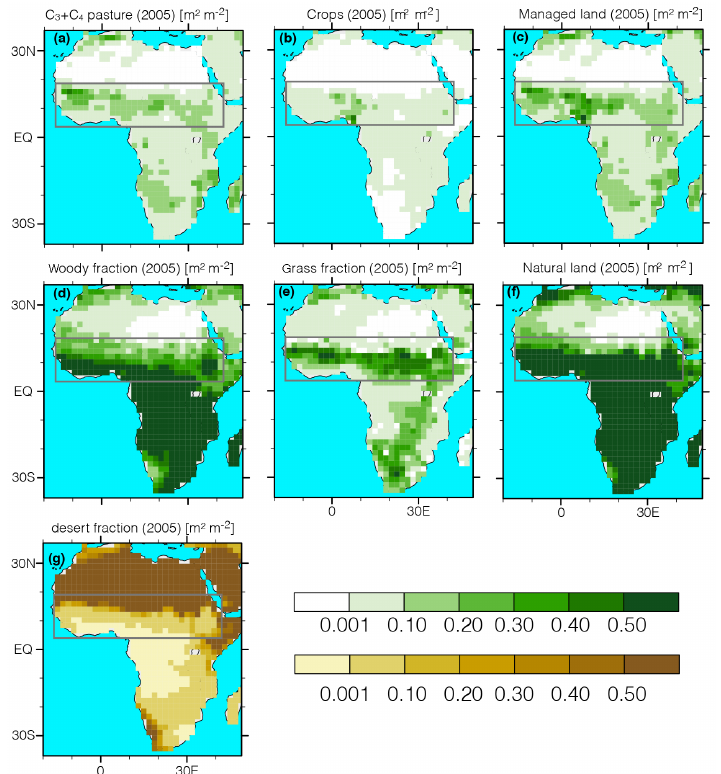
Figure 2. Ensemble mean of the cover fraction([m 2 m − 2 ) of managed land (top), natural vegetation (middle), and desert fraction (bottom) at the end of the historical simulation (year 2005) simulated by MPI-ESM. The managed land is shown for (a) pasture, (b) crops, and (c) total fraction. The natural vegetation is shown for (d) woody vegetation, (e) grass land, and (f) total